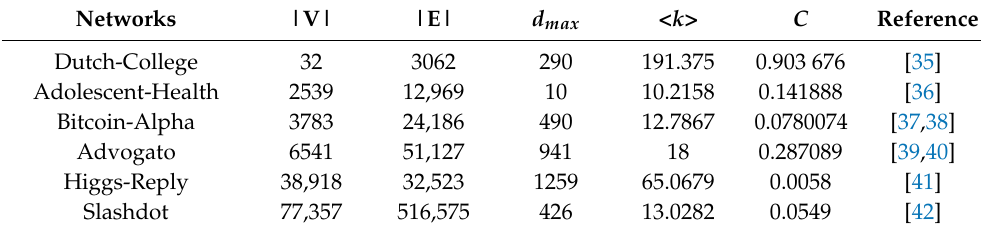
Table 1. Topological structure and properties of experimental network data set.